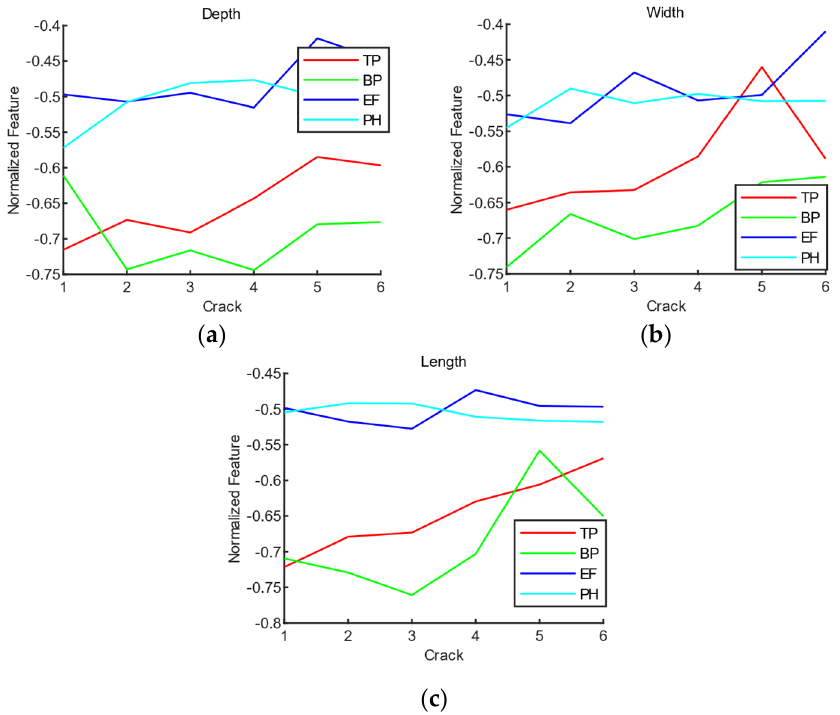
Figure 10. Stainless steel crack sensing results: ( a ) depth, ( b ) width, and ( c ) length.